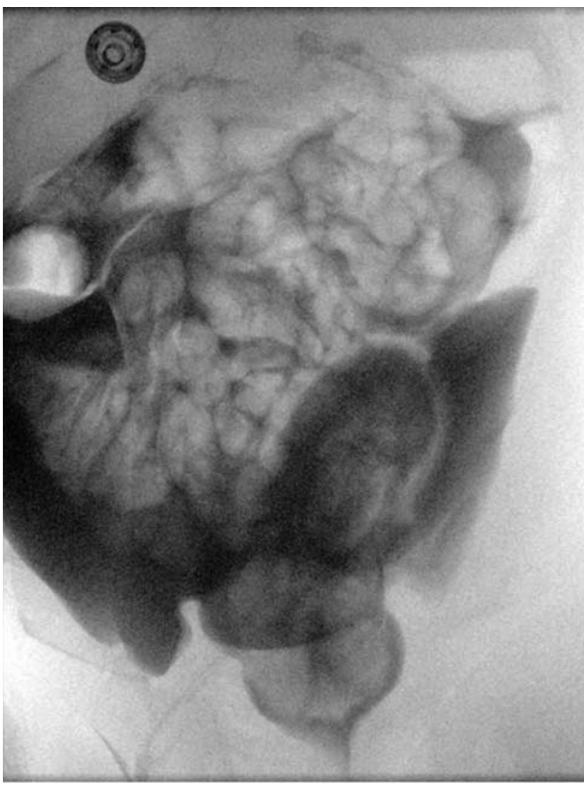
Fig. 2 Case 1. High-pressure distal colostogram anteroposterior view showing the massive intraperitoneal extravasation of Urogra fi